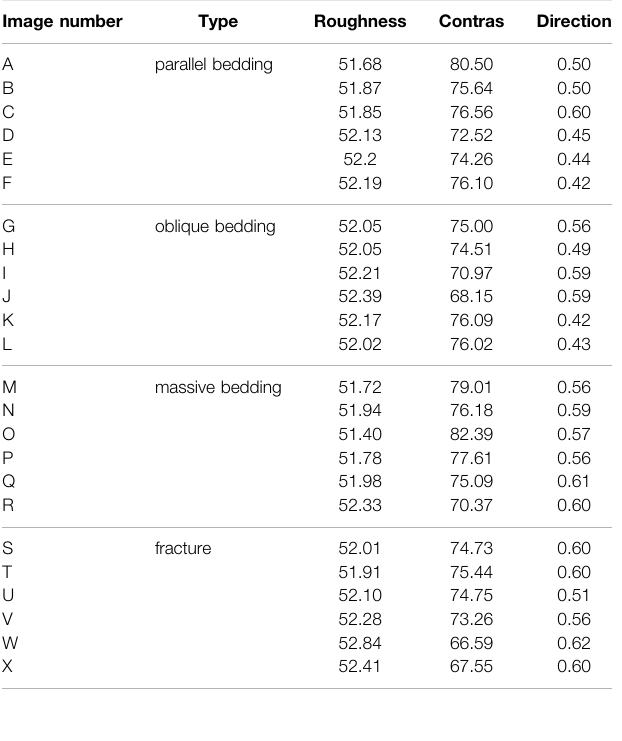
TABLE 1 | Calculation results of roughness, contrast and directionality of imaging well logs of 4 types of heterogeneous intervals in well A. Image number Type